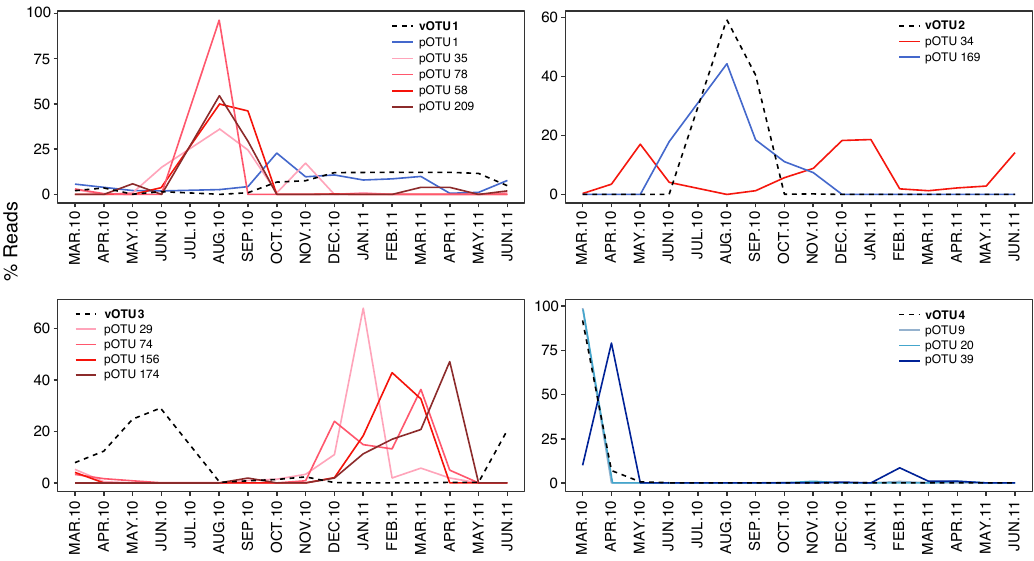
Figure 5. Temporal distribution of the four most abundant viruses, vOTU1-4, and their co-occurring protists. Virus OTU relative abundances are represented with dotted lines, those of pOTUs with continuous lines. Red lines indicate negative correlations between virus and protists, blue lines indicate positive correlations.